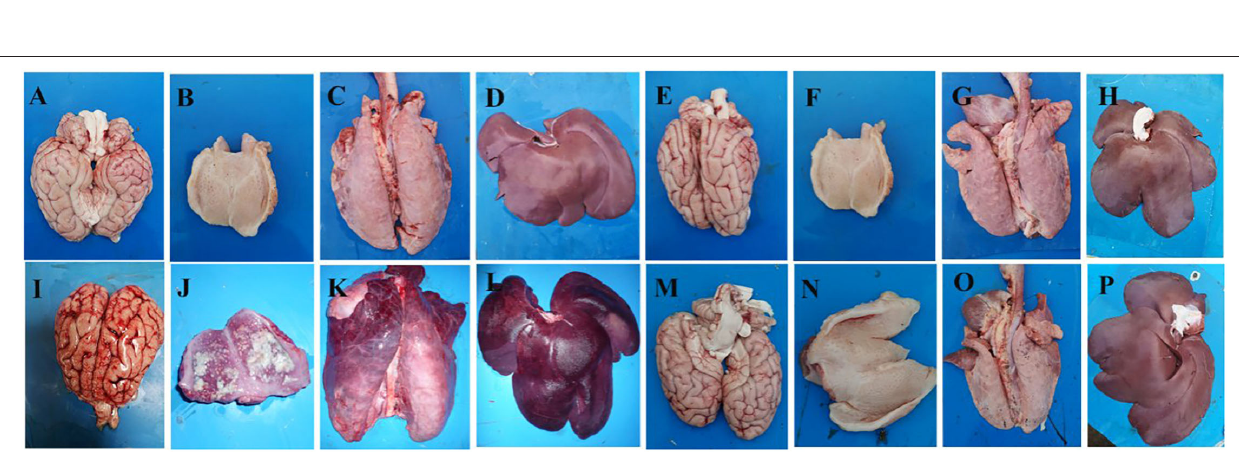
rPRV/XJ5-gI − /gE − /TK − -challenged group ( Figure 4 ). Virus Shedding Virus shedding appeared in all the vPRV/XJ-5 strain-challenged pigs after 2– 6 d.p.c. ( Figures 5A,B ). The results indicate that the vaccination debased the amount and duration of virus